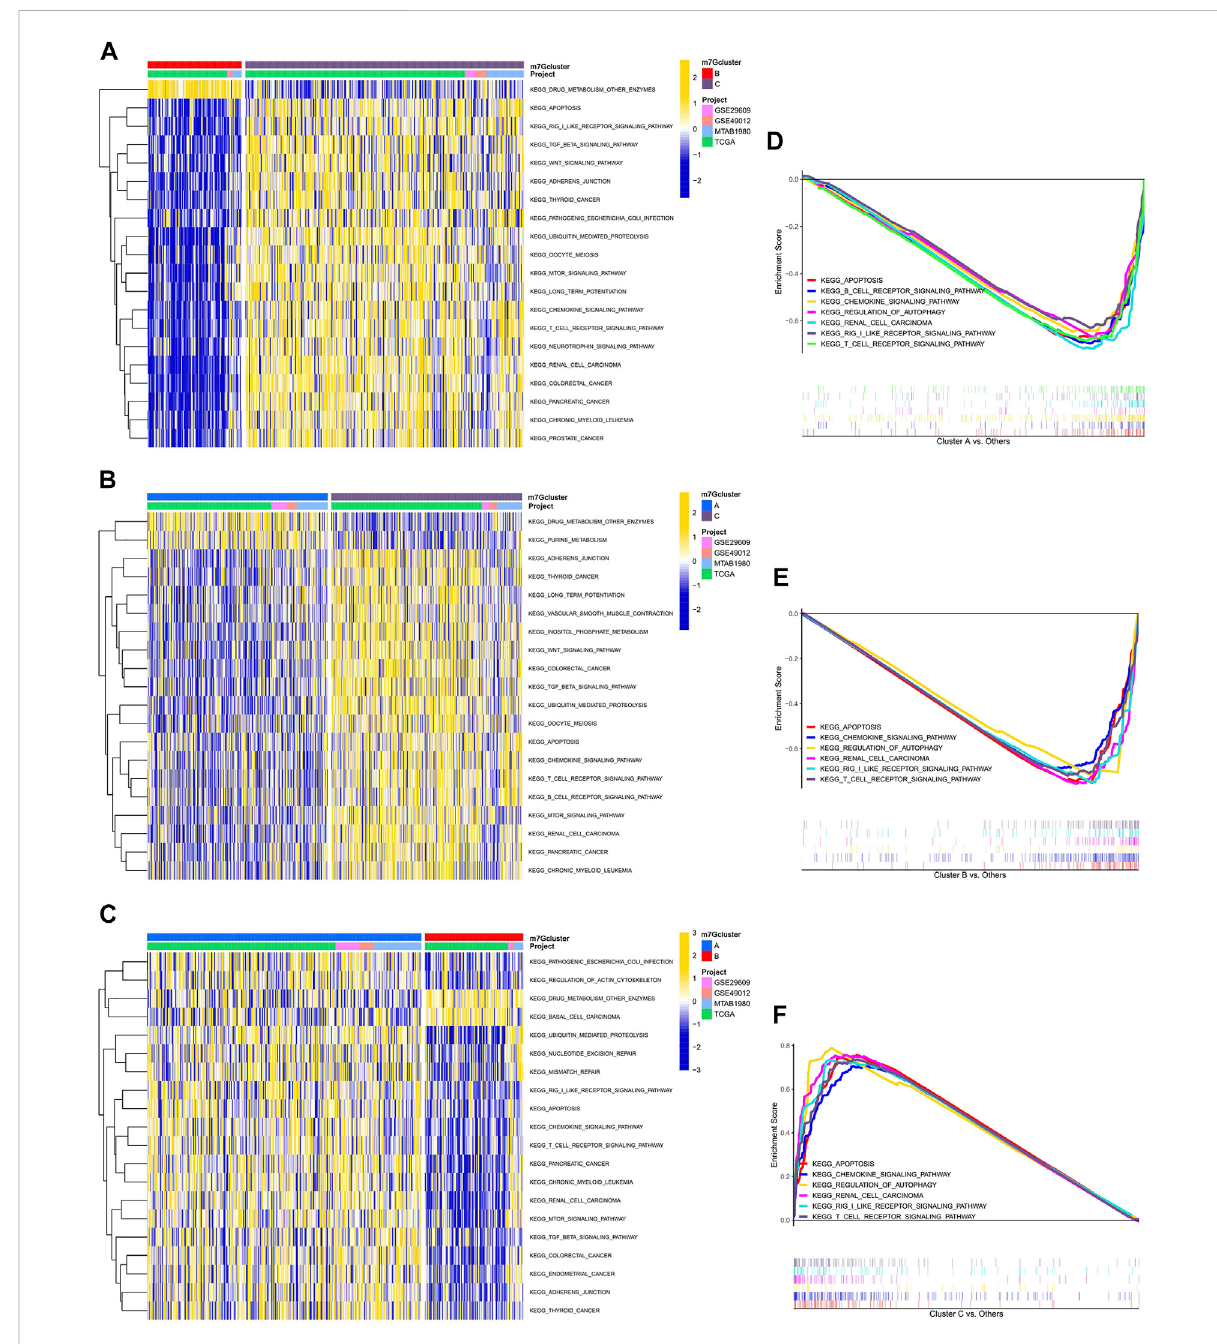
FIGURE 2 Enrichment analysis among different subtypes. (A) Pathway enrichment analysis between m7G clusters B and C. (B) Pathway enrichment analysis between m7G clusters A and C. (C) Pathway enrichment analysis between m7G clusters A and B. (D – F) Gene enrichment analysis among different